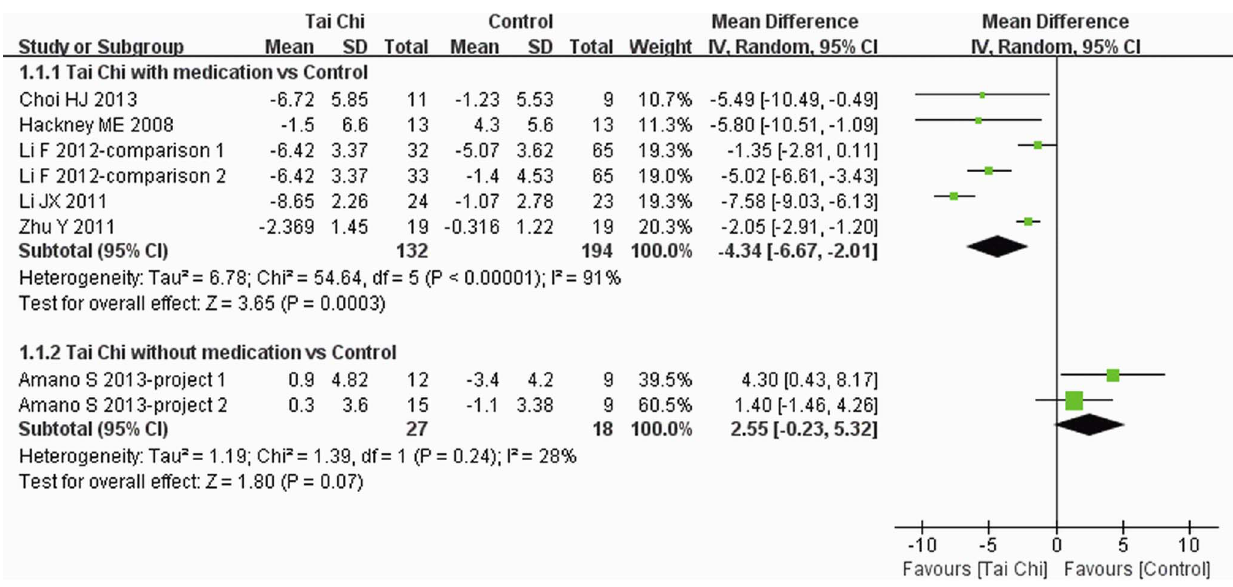
Figure 3. The effect of Tai Chi on UPDRS III score. Subgroup analysis was performed according to whether or not medications were included in the intervention. A random model was used to address the high heterogeneity. UPDRS III, Unified Parkinson’s Disease Rating Scale Part III.